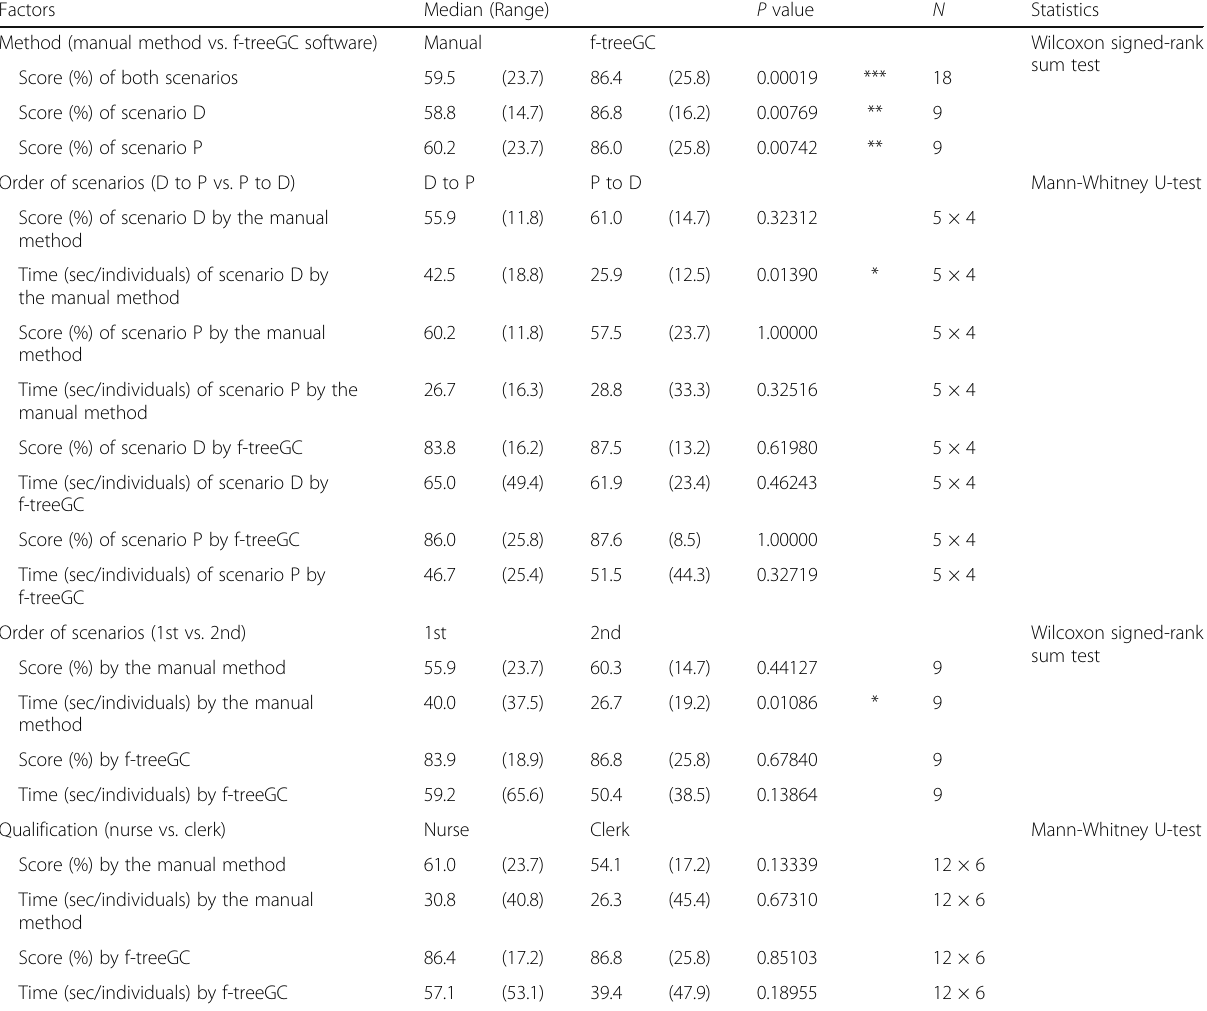
Table 4 Comparison of pedigree scores and creation time for each factor Factors